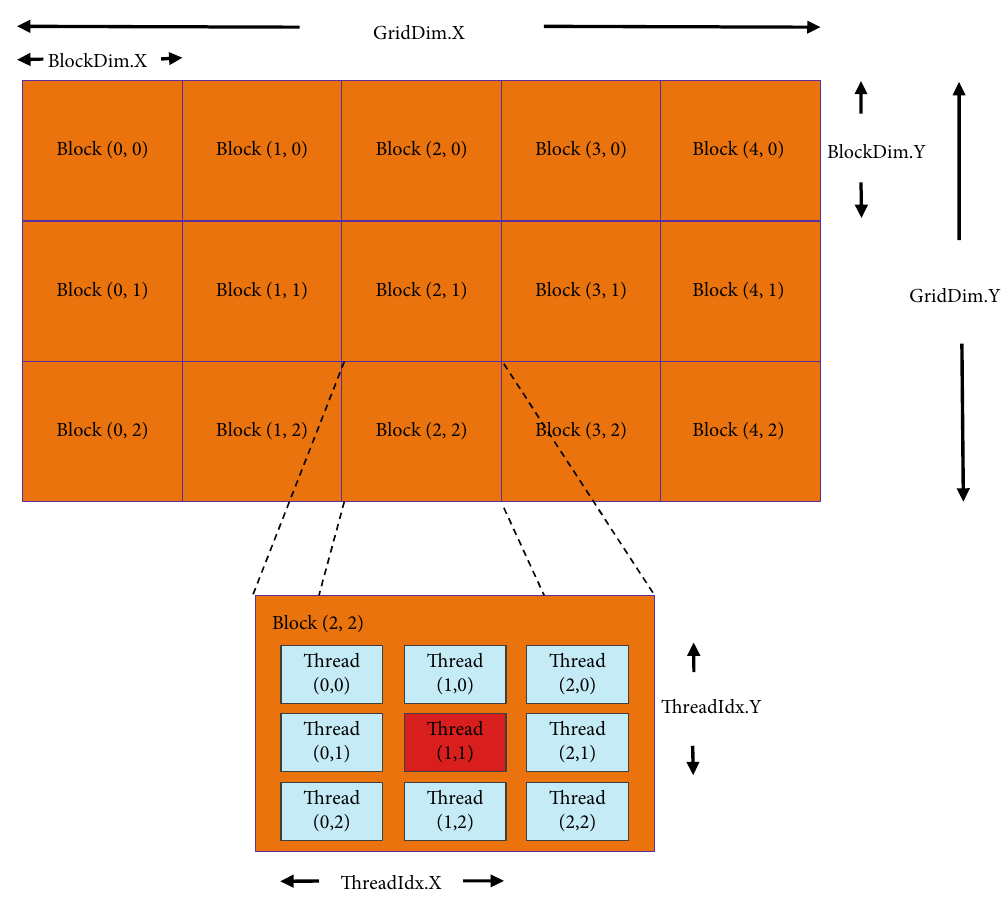
Figure 9: CUDA thread index